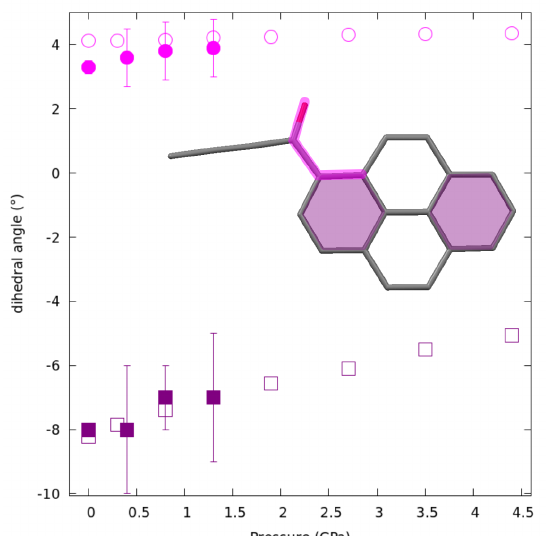
Figure 5. Variation of the C=O out-of-plane rotation (purple squares) and the angle between terminal benzene rings (magenta circles) with pressure. Experimental results represented by filled markers with uncertainties, results of theoretical calculations by empty